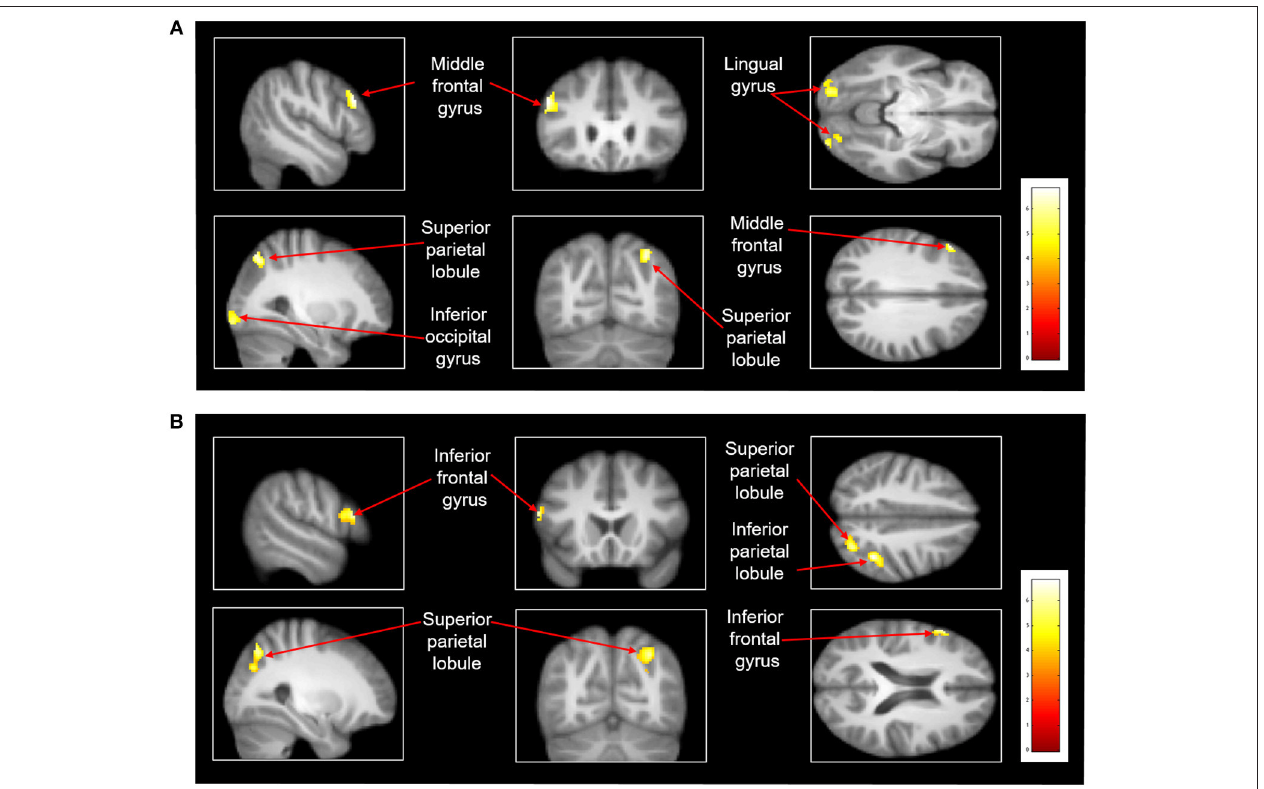
FIGURE 4 | Heat map demonstrating areas with greater activation in the (A) imagined slipping condition and (B) imagined walking condition after 3 consecutive days of treadmill-slip perturbation training. Increased activation was noted in different regions in the frontal, parietal, and occipital lobes ( p < 0.01, k